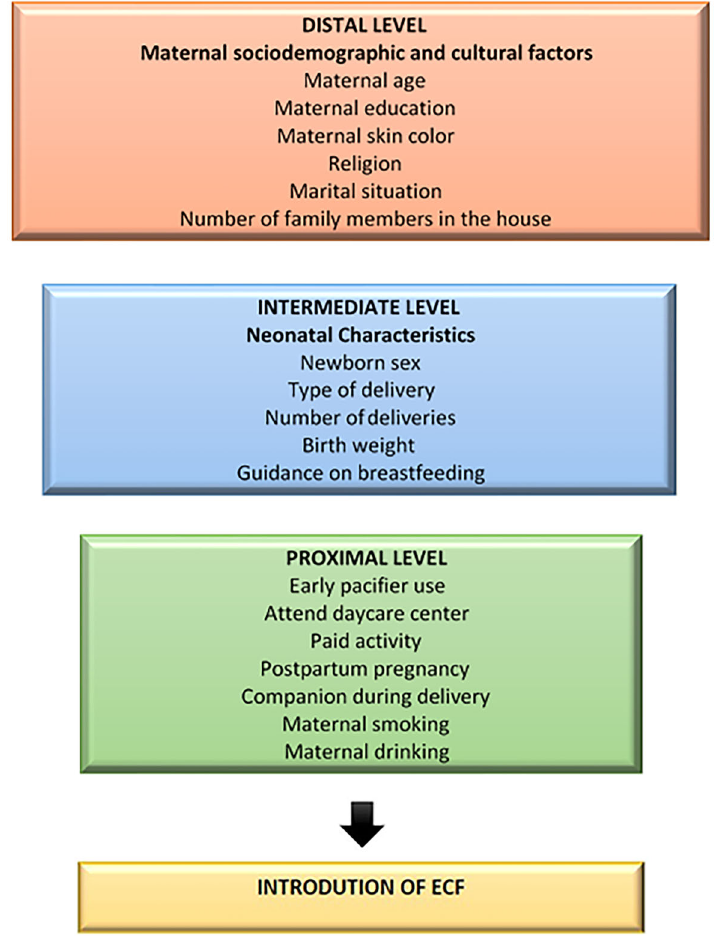
Figure 2. Hierarchical theoretical model. ECF: early complementary